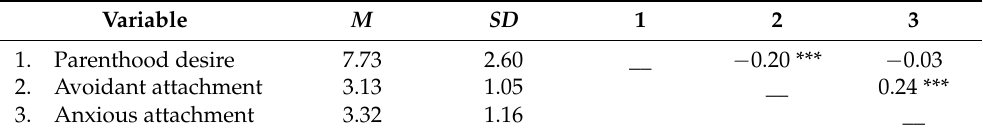
Table 2. Pearson correlations between the main study